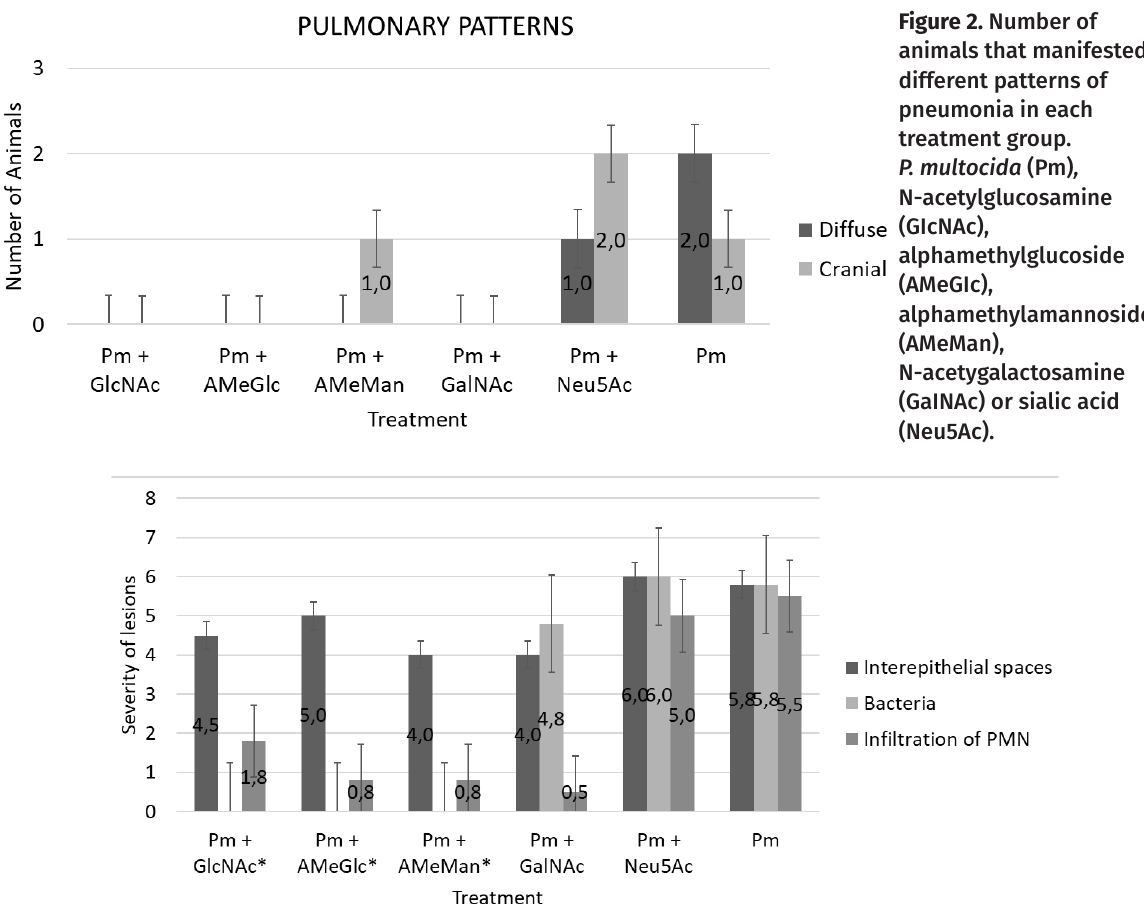
Figure 3. Degree of severity of microscopic changes in the respiratory epithelium of the rabbit nasal septa in groups exposed to P. multocida + individual carbohydrates or to P. multocida alone (*P<0.05). P. multocida (Pm) , N-acetylglucosamine (GIcNAc), alphamethylglucoside (AMeGIc), alphamethylmannoside (AMeMan), N-acetylgalactosamine (GaINAc) or sialic acid